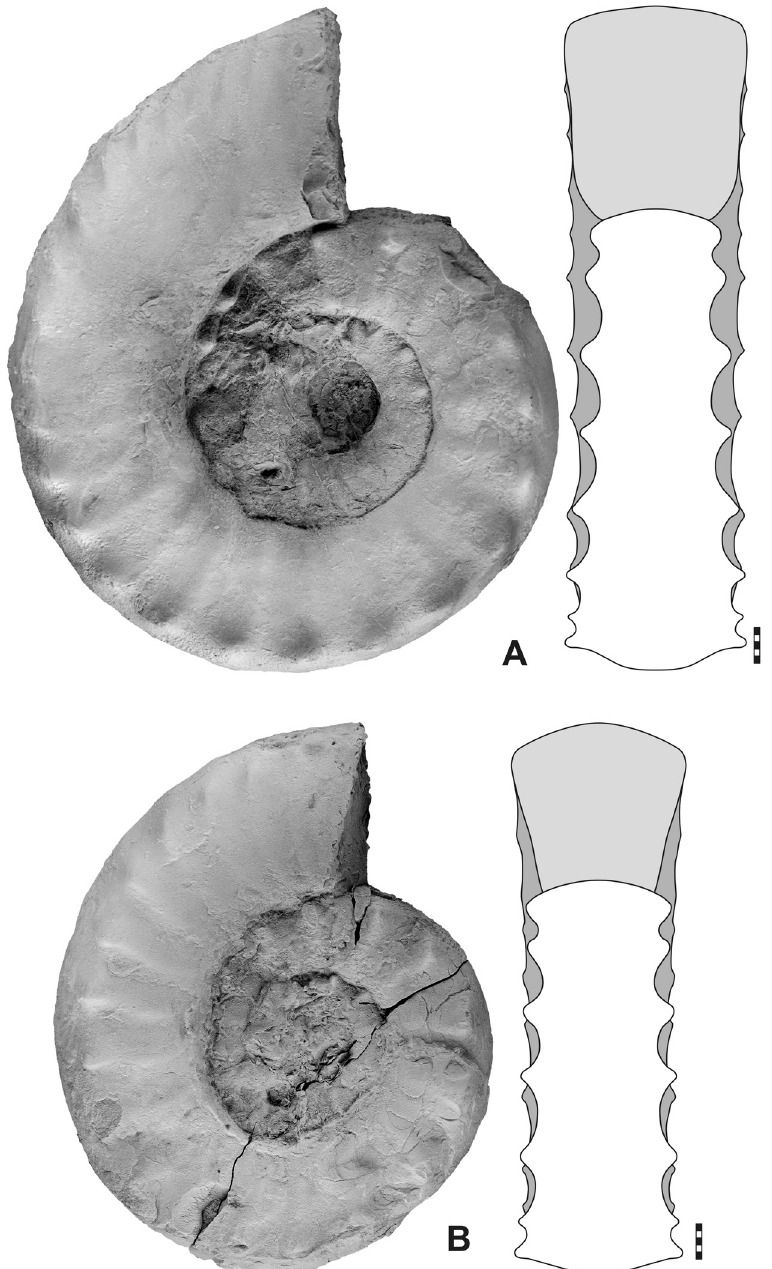
Fig. 42. Clivotirolites decoratus Korn & Hairapetian gen. et sp. nov., lateral and dorsal views. A . Paratype MB.C.29938, section 1, -1.50 m. B . Paratype MB.C.29944, section E, float. Scale bar units = 1